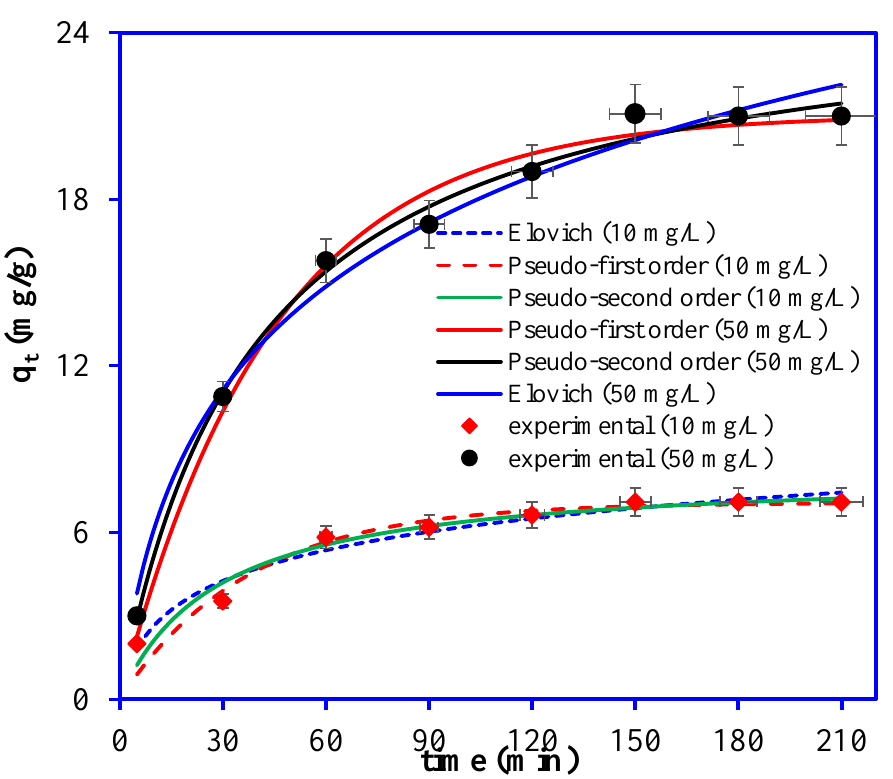
Figure 11. Plot for OTC adsorption kinetics onto Ni 3 S 4 /Ag 2 S/TiO 2 /CA aerogel. (OTC conc.: 50 mg/L, aerogel mass: 0.03 g, OTC volume: 30 mL, time: 180 min, pH: 6).